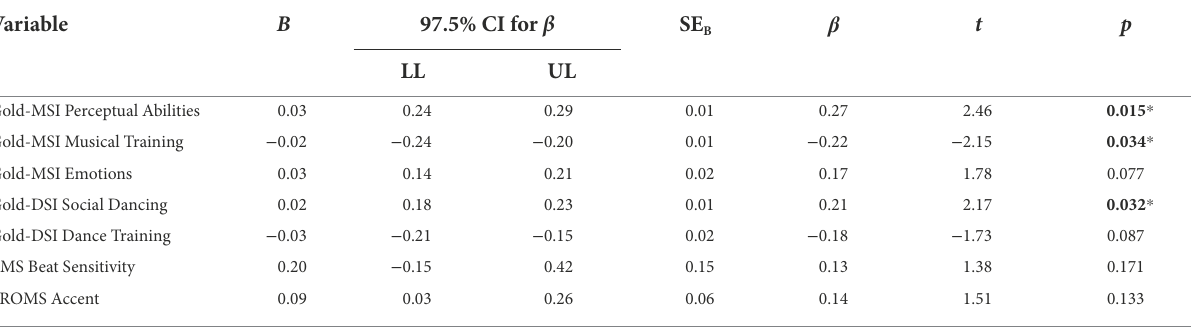
TABLE 4 Stepwise multiple linear regression